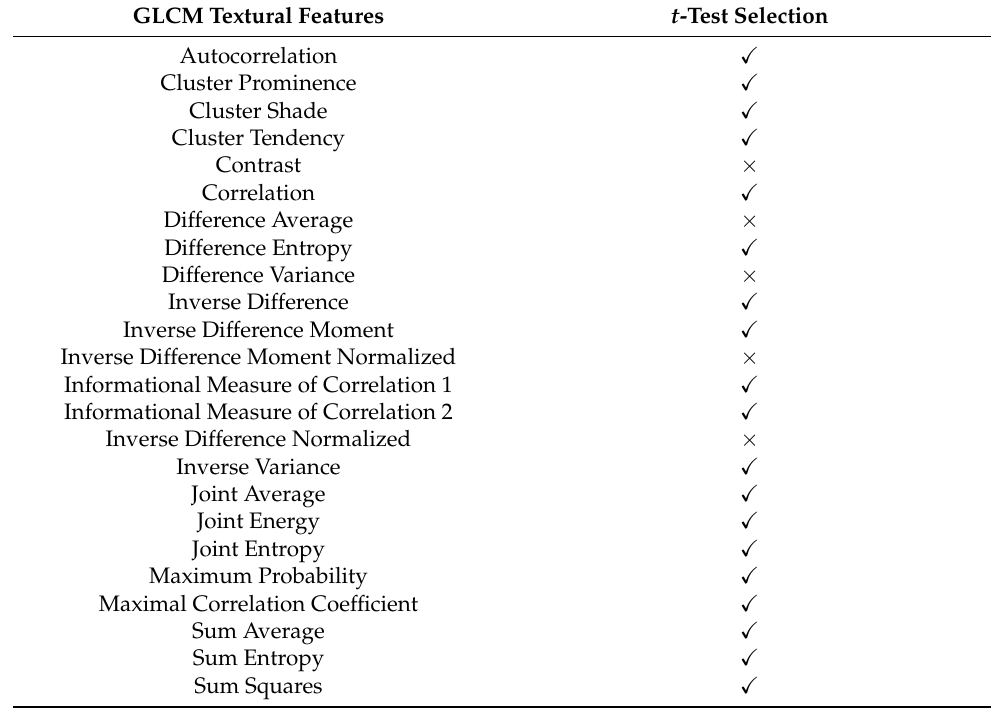
Table 3. GLCM Features Selected with the t -test. The first column lists the 24 GLCM textural features. The second one indicates the 19 GLCM features selected by the t -student test with a (cid:88) .